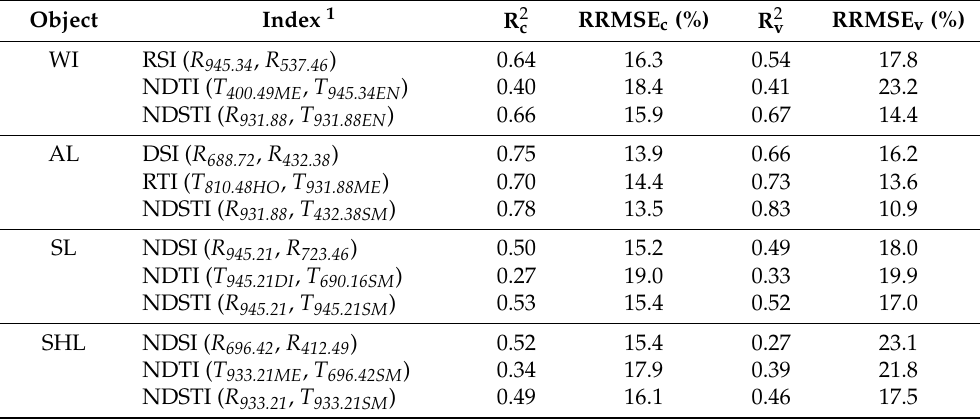
Table 7. The optimal spectral index (SI), textural index (TI), and spectral and textural index (STI) of the four objects, and the corresponding statistics for LNC estimations and